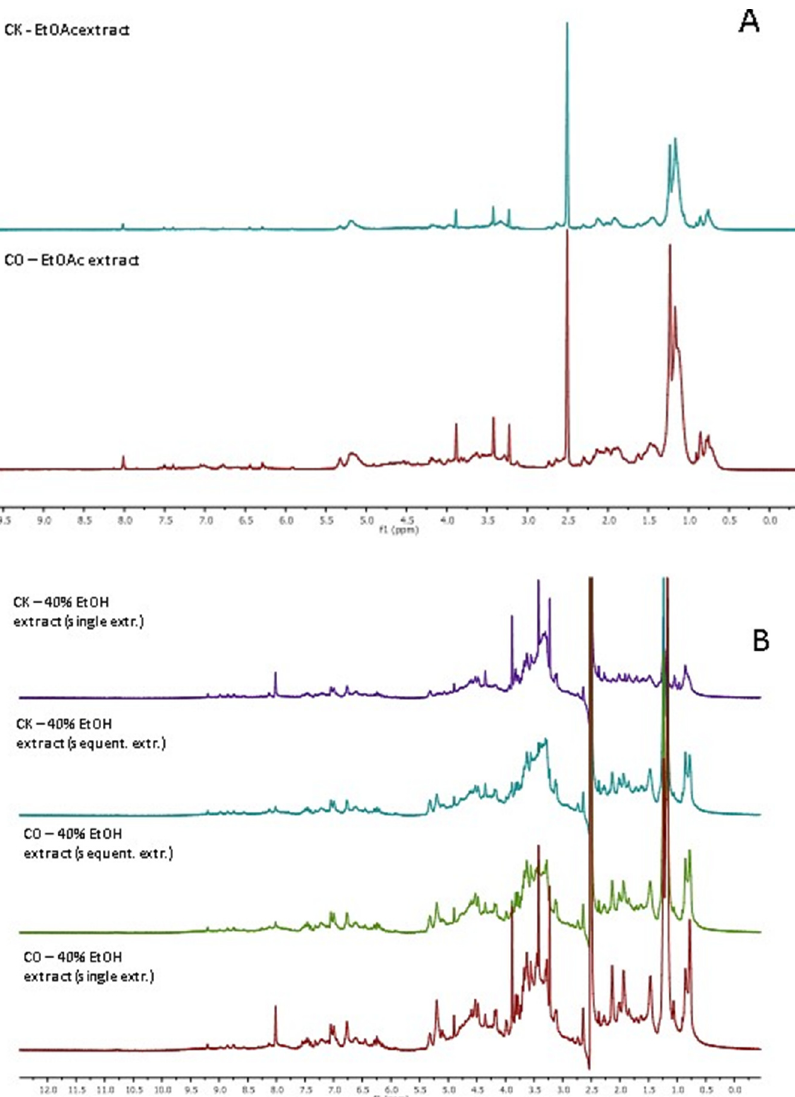
Figure 8. ( A ) CK and CO spent coffee ground 1 H NMR spectra for ethyl acetate extracts (500 MHz, DMSO-d6). ( B ) CK and CO spent coffee ground 1 H NMR spectra for 40% ethanol extracts (500 MHz, DMSO-d6).